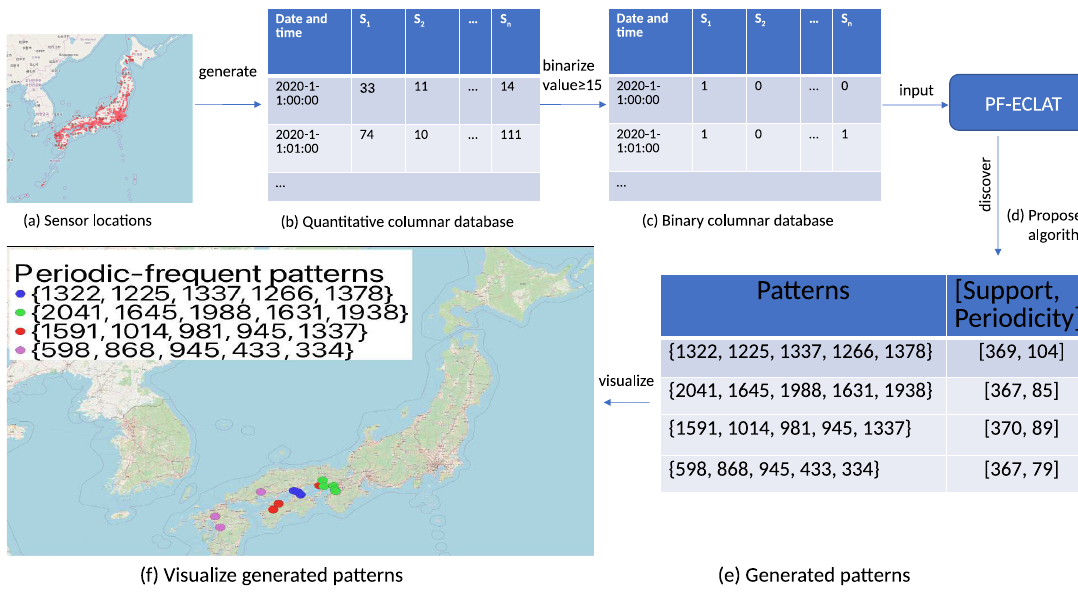
Figure 11. Finding periodic-frequent patterns in the Pollution database. The terms ‘ s 1 ’, ‘ s 2 ’, · · · ‘ s n ’ represents ‘sensor